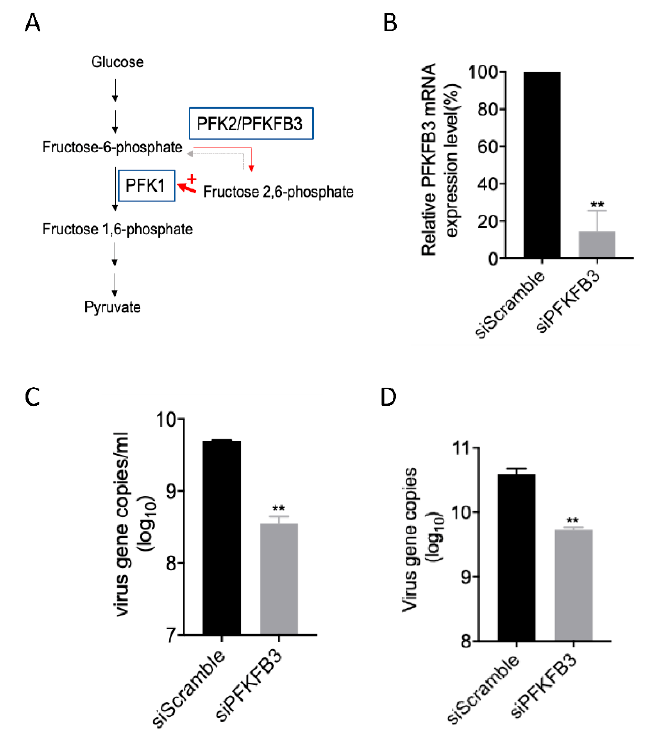
Figure 4. 6-phosphofructo-2-kinase (PFKFB3) is crucial for EV-A71 replication. ( A ) Schematic representation of the function of PFKFB3 in the host glucose metabolism. Fructose-2,6-biphosphatase 3, also known as PFKFB3, is a rate-limiting enzyme of glycolysis, which converts fructose-6-phosphate to fructose-2,6-bisphosphate (F2,6 BP). A red + indicates F2,6 BP facilitating the enzyme activity of 6-phosphofructokinase-1 (PFK1) which catalyzes fructose-6-phosphate to fructose-1,6-phosphate. ( B ) 100 nM siPFKFB3 or siScramble was transfected into RD cells for 24 h and then infected with EV-A71 (MOI = 0.05). Supernatant and cell lysates were collected after another 24 h before viral load detection. Knockdown efficiency was evaluated by qRT-PCR assay. PFKFB3 mRNA expression level was reduced when compared to that of the scramble-siRNA treated group. siPFKFB3 knockdown decreased EV-A71 gene copies both in the ( C ) supernatant and ( D ) cell lysates of the infected RD cells. All the experiments were performed in triplicates. Data are shown as means ± SEM. ** denotes p < 0.01 when compared with the scramble-siRNA treated group. Student’s t -test.